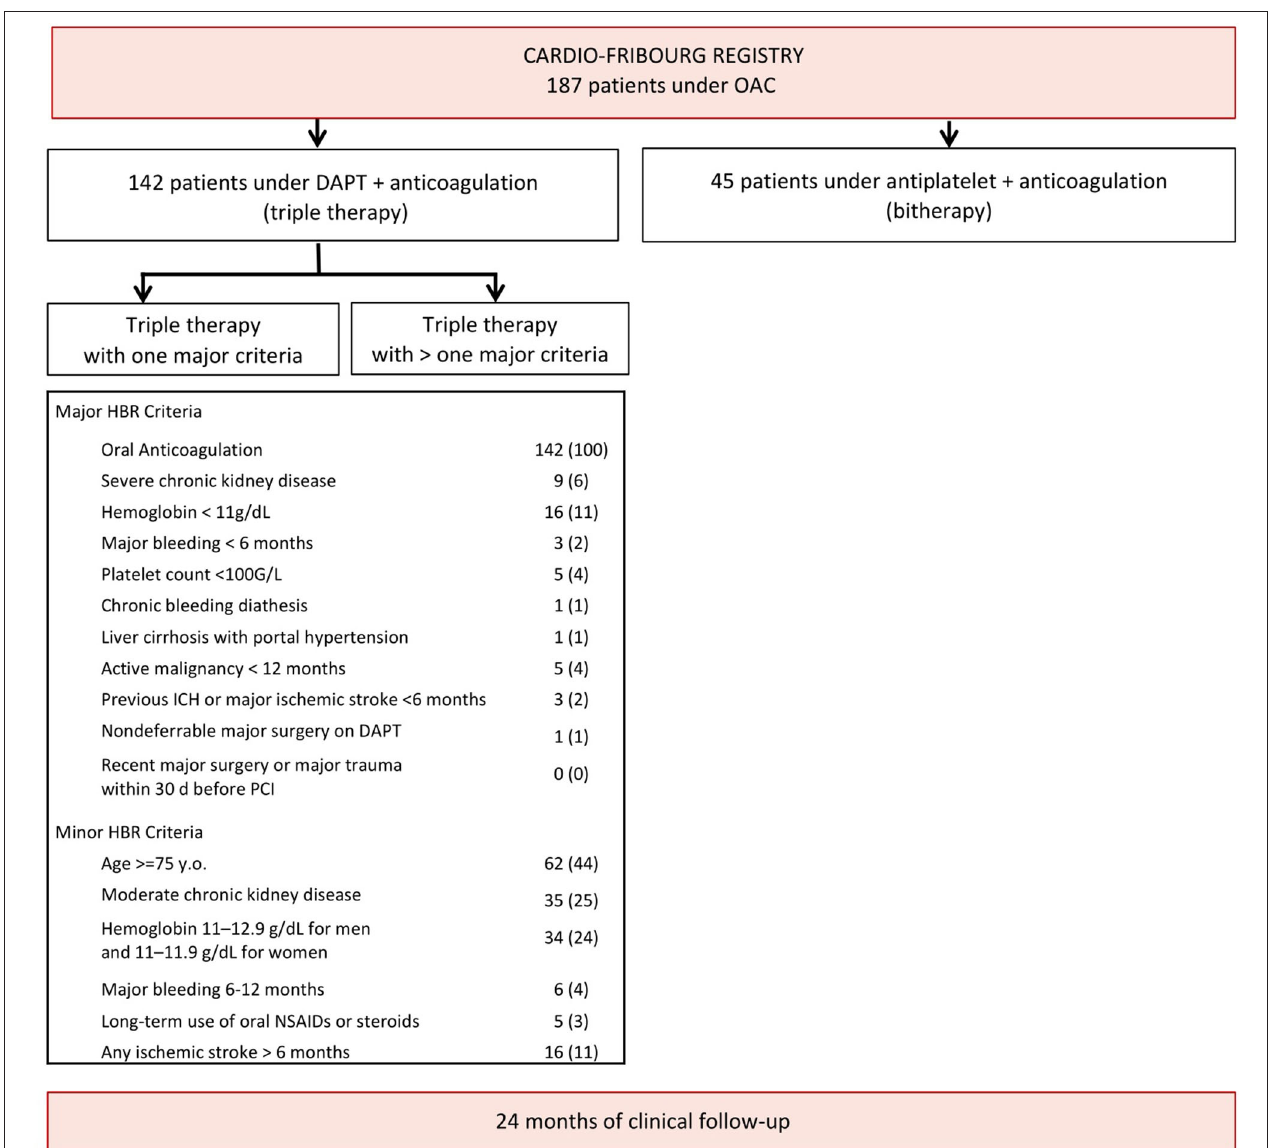
FIGURE 1 | Study flow chart. DAPT, dual-antiplatelet therapy; HBR, high bleeding risk; ICH, intracerebral hemorrhage; NSAID, non-steroidal anti-inflammatory drugs; OAC, oral anticoagulation; PCI, percutaneous coronary